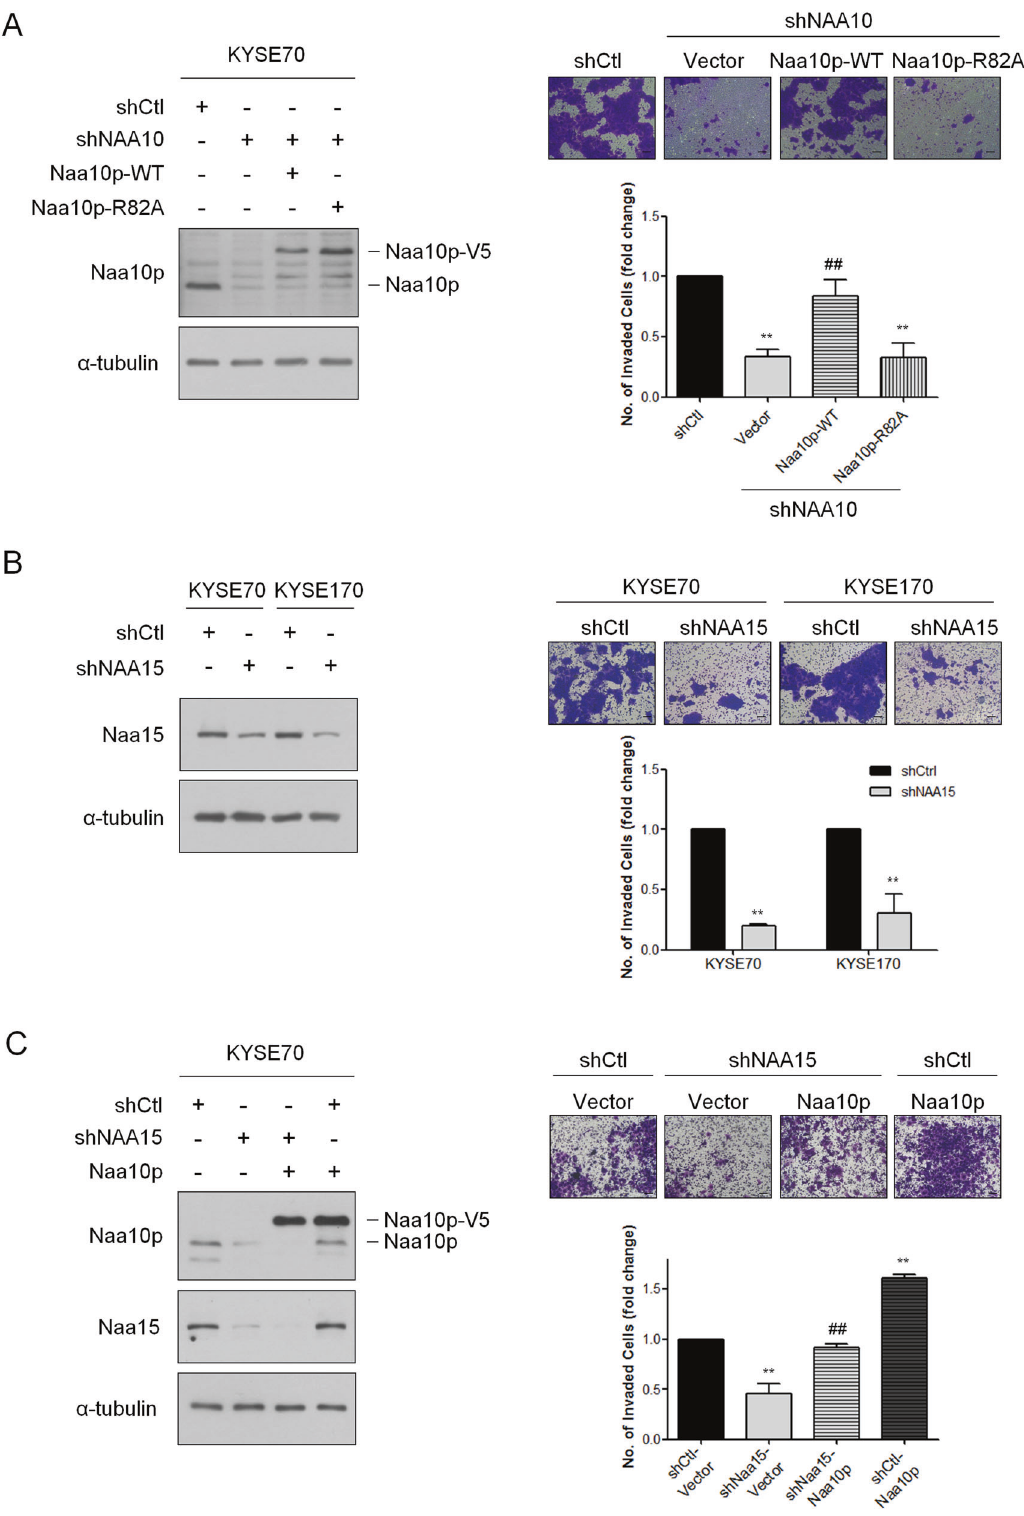
Naa10p-depleted KYSE70 cells. As shown in Fig. 7B – D, successful reduction of either Cystatin E/M, PAI1, or TIMP2 by shRNAs in Naa10p-depleted KYSE70 cells was con fi rmed by western blotting. Despite that both PAI1- and Cystatin E/M- silencing show some rescue effects, only the PAI1 knockdown groups